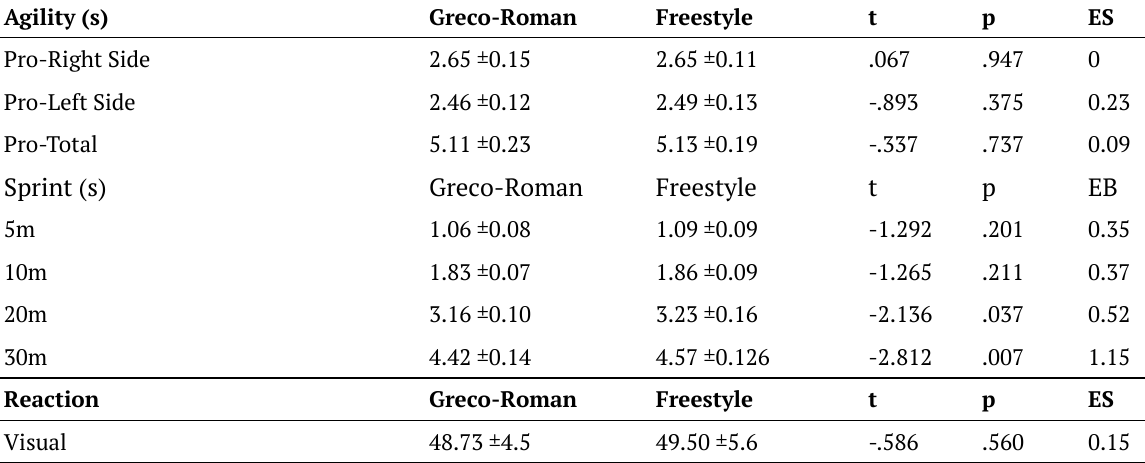
Table 4. Comparison of agility, speed, and reaction.